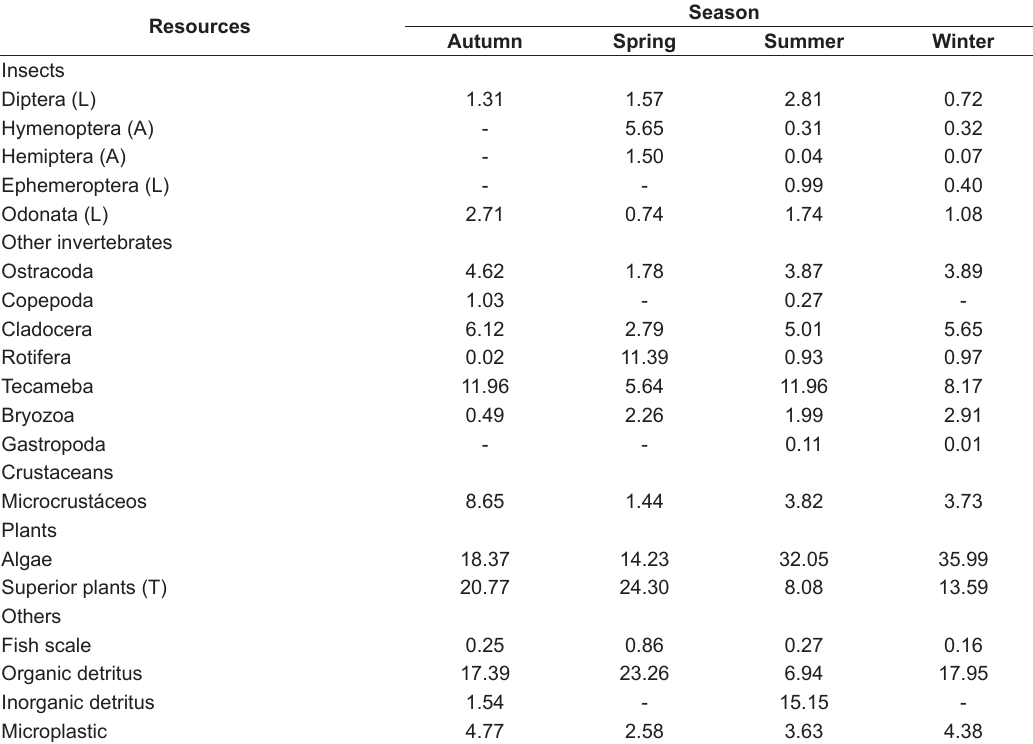
Table 1. Volume (%) of food items identified in stomach contents of Serrapinnus notomelas in a lagoon located on the Tibagi River, Upper Paraná River Basin, in the municipality of Sertanópolis - PR.